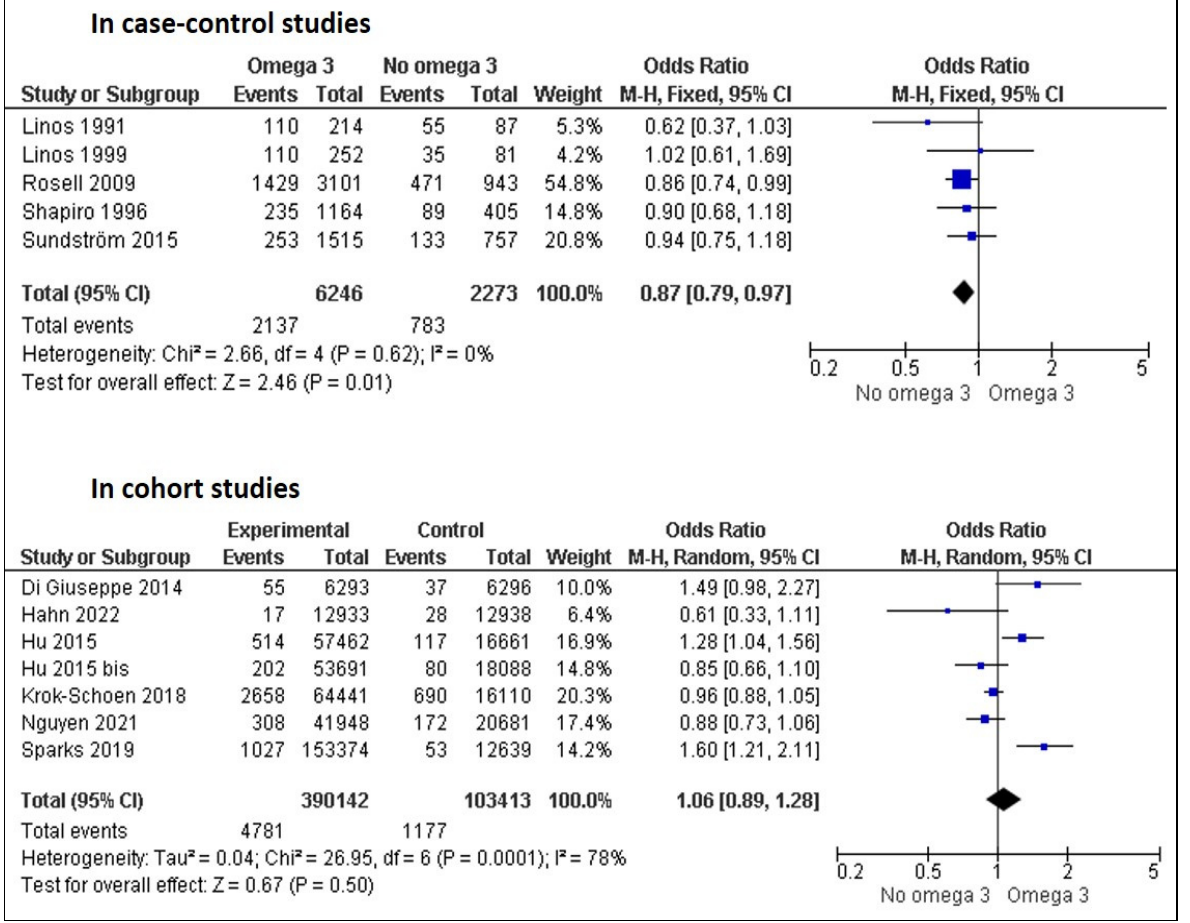
Figure 3. Forest plot of the risk of RA occurrence between omega 3 users and non-users depending on the type of studies.